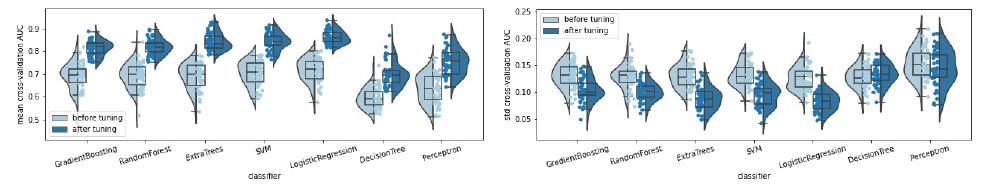
Figure 10. Distribution (displayed by violin plot, box plot, and strip plot) of the mean and STD cross-validation AUC values before and after the pipeline tuning process, for predicting ( a ) the tumor grade, ( b ) IDH mutation status, and ( c ) 1p/19q codeletion status of the gliomas. Each reported point corresponds to a sample random run within 51 random